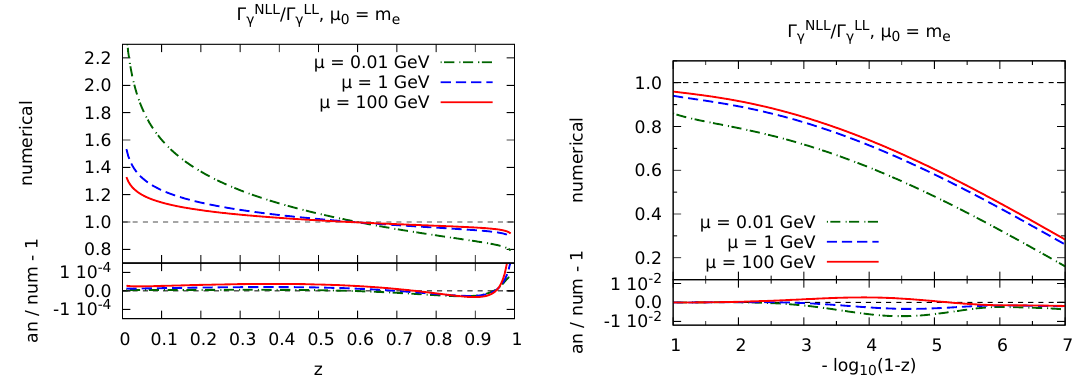
Figure 11 . As in (cid:12)gure 9, for the